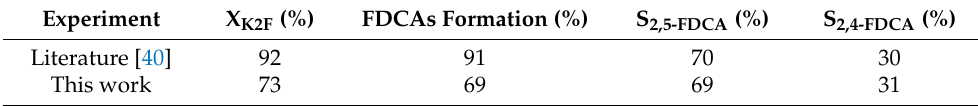
Table 1. Validation of the experimental setup for the Henkel reaction, using the Kugelrohr apparatus. Experiment X K2F (%) FDCAs Formation (%) S 2,5-FDCA (%) S 2,4-FDCA (%) Literature [40] 92 91 70 30 This work 73 69 69